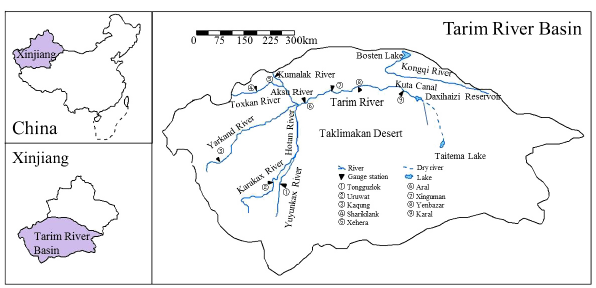
Fig. 2. Overview of Tarim River basin and its river system (adapted from Hao et al.,